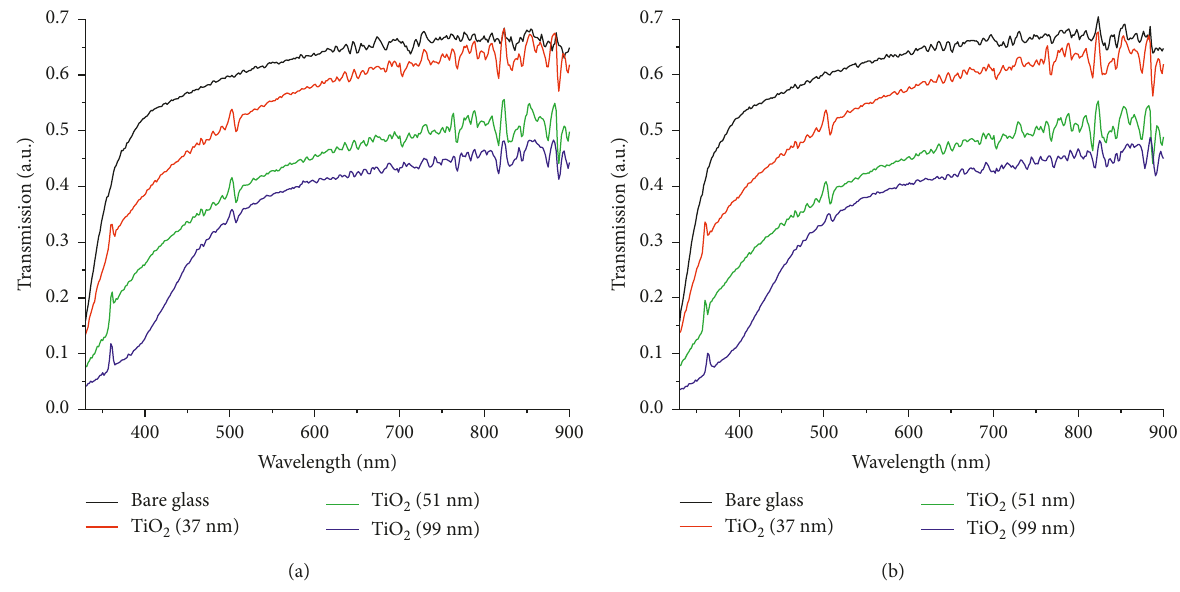
Figure 8: Transmission spectra of TiO 2 thin films with thickness of 37 nm, 51nm, and 99nm in air (a) and CO 2 gas flow (b).